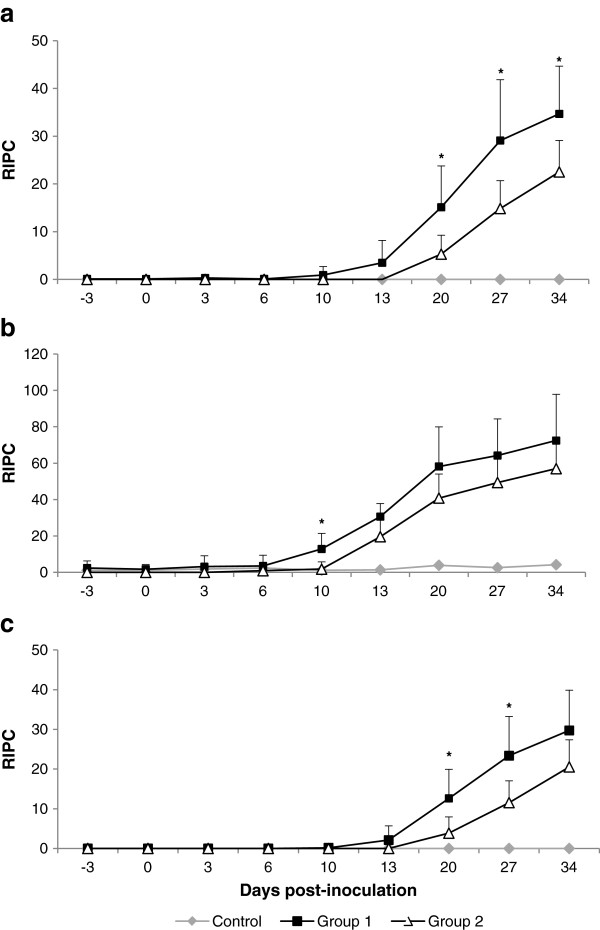
IgG humoral immune responses. Serum levels of total IgG (a), IgG1 (b) and IgG2 (c) antibodies against N. caninum. Immunoglobulin levels are expressed as a relative index percent (RIPC) according to formula: RIPC = (OD405nm sample - OD405nm negative control)/(OD405nm positive control - OD405nm negative control) × 100. Each point represents the mean + SD at the different sampling times. (*) Indicates significant differences (P < 0.05) between the two infected groups (G1 and G2). Data for 49 dpi are not represented because only one heifer from G1 and two heifers from G2 maintained pregnancy.